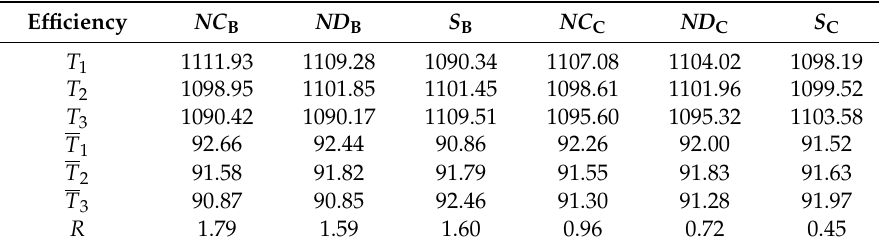
Table 3. Range analysis of the orthogonal test results.